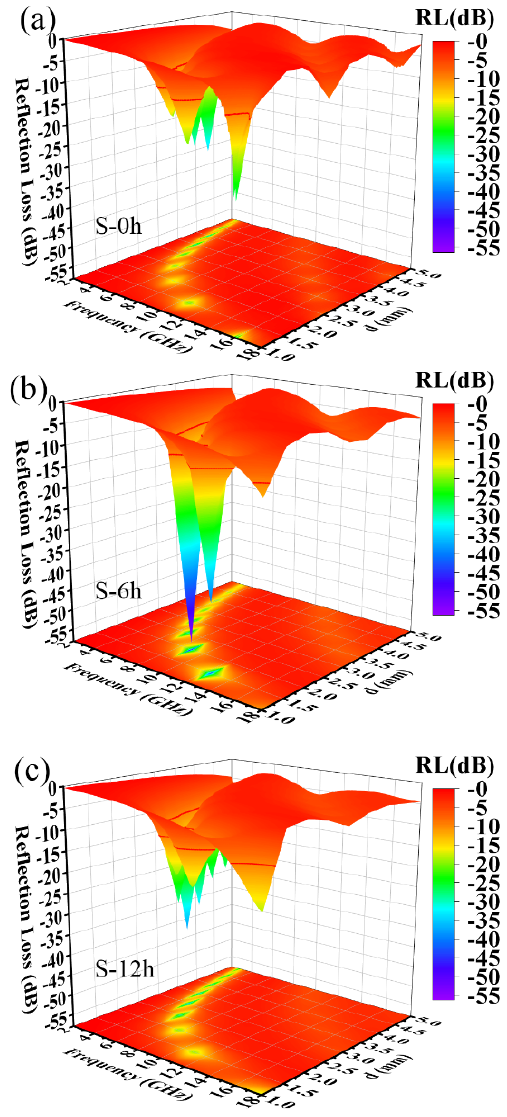
Figure 4. RL − 3D curves of NiCoMnSn alloy flakes samples: ( a ) S-0h, ( b ) S-6h, and ( c ) Table 1. A comparison with the microwave absorption parameters of the typical ferromagnetic MAMs with paraffin matrix.